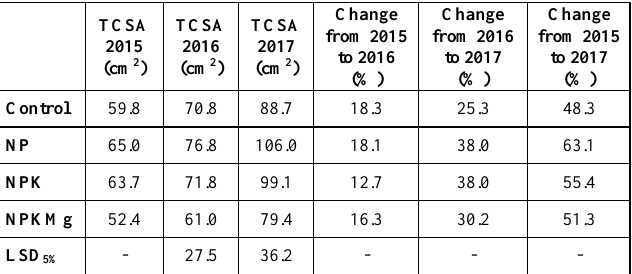
Table 3 . Trunk cross sectional area (TCSA) (Debrecen - Pallag, 2015-2017).